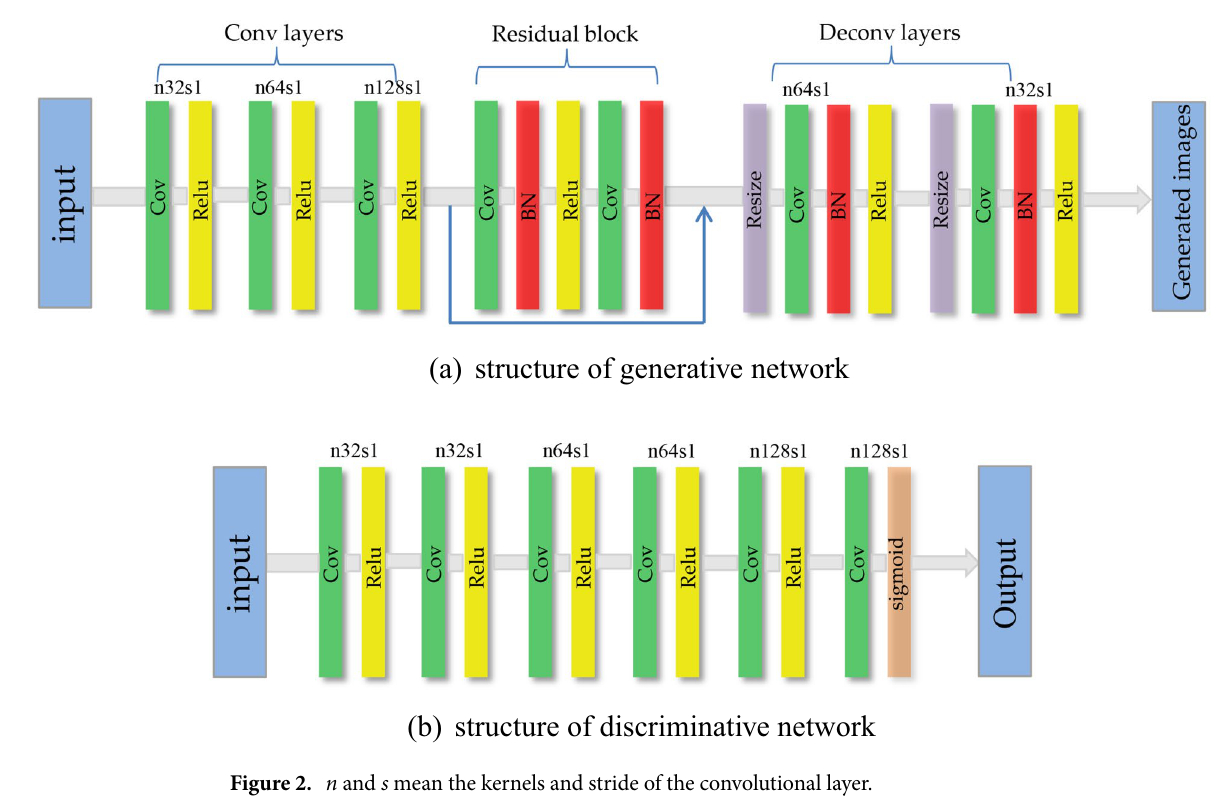
Figure 2. n and s mean the kernels and stride of the convolutional